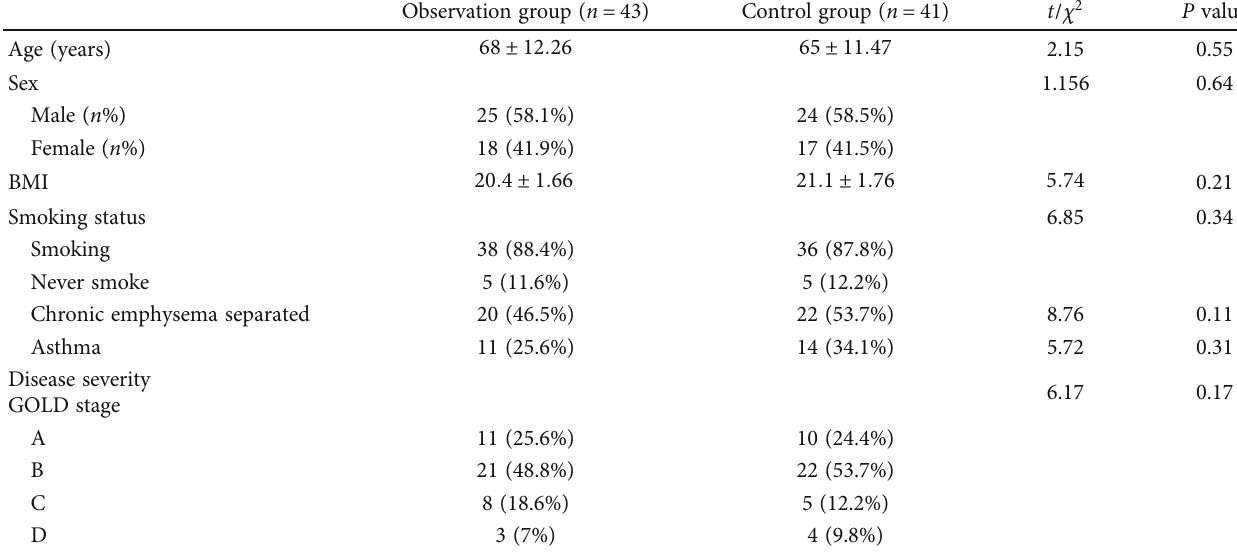
Table 1: Comparison of clinical data between the two groups.